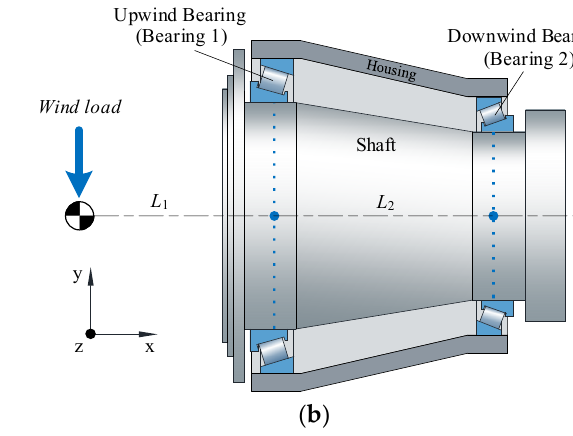
Figure 2. Structure and load of wind turbine spindle. ( a ) Load direction coordinate system; ( b ) Structure and load. Table 1. Geometrical parameters of bearings.